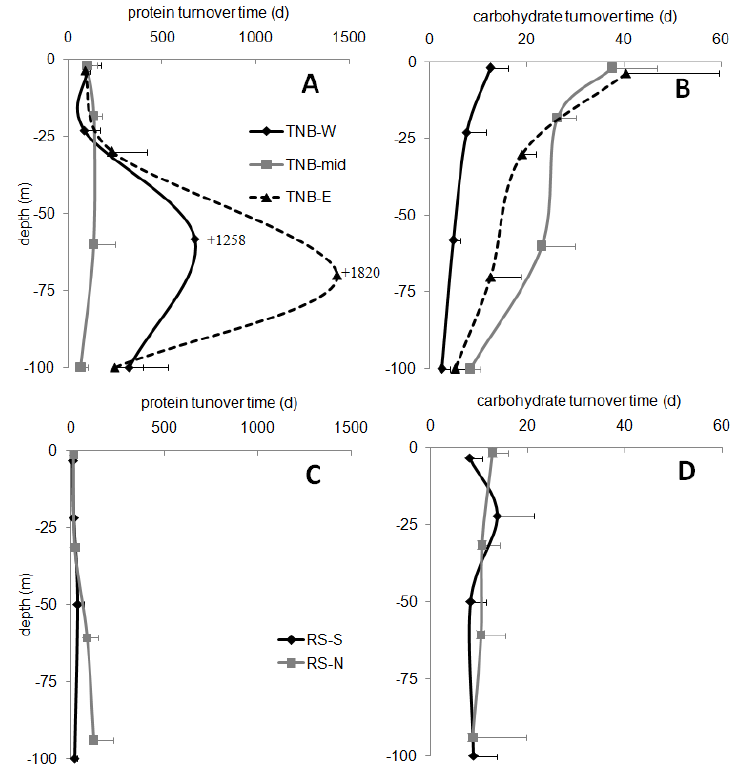
Figure 7. Turnover times of proteins and carbohydrates in the coastal-TNB macro-area (upper panels A , B ) and in the RS-o ff shore macro-area (lower panels C , D ).